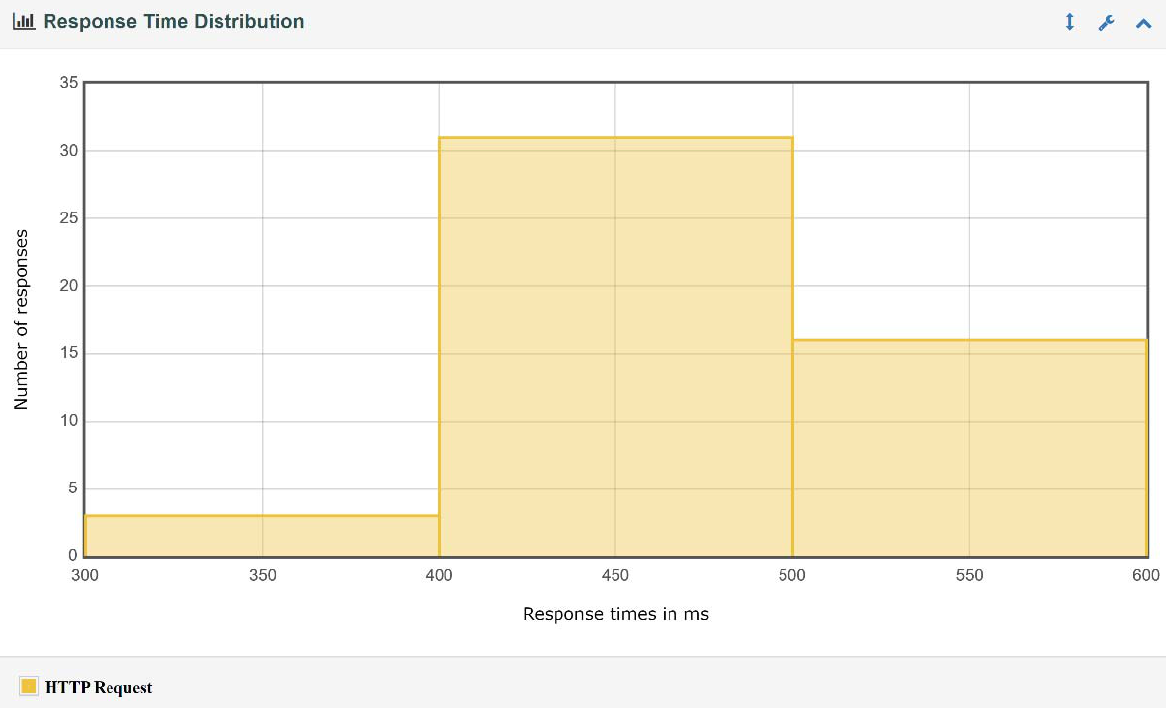
Figure 9. Response time distribution for 50 edge nodes and the IBM Cloud.